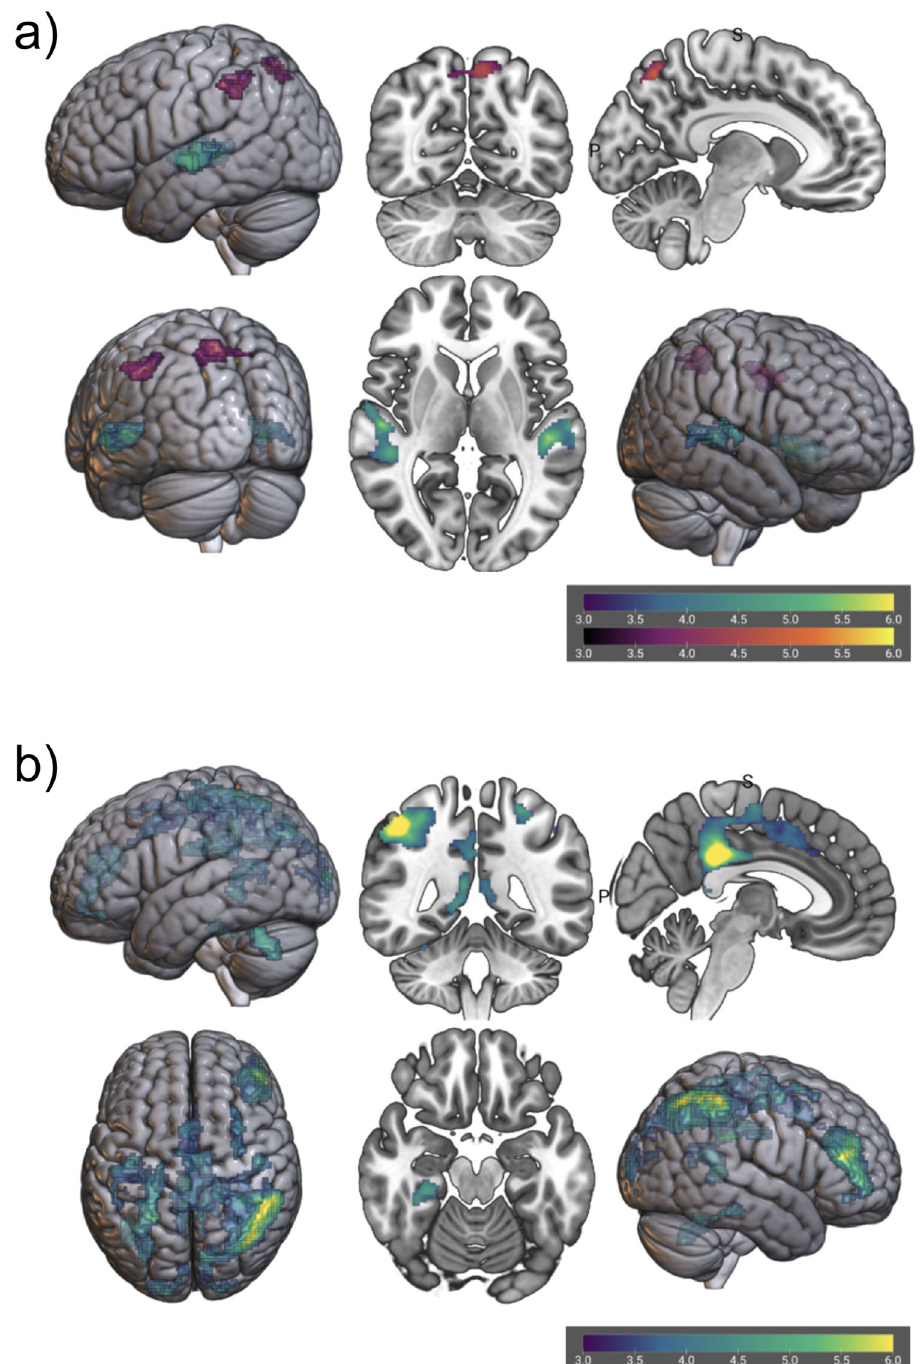
Fig. 2 Whole-brain analysis results for literariness and emotional intensity ( N = 52). a Brain correlates of appraised literariness during narrative engagement signi fi cant at permutation-based combined cluster-voxel-extent threshold (positive correlates in purple and negative correlates in cyan). The general linear model parametrically modelled semantic events for literariness. All within-cluster voxels are family-wise error corrected at p < 0.05. b Brain correlates of appraised emotional intensity during narrative engagement signi fi cant at permutation-based combined cluster-voxel-extent threshold (only negative correlates survived thresholding, in cyan). The general linear model parametrically modelled semantic events for emotional intensity. All within- cluster voxels are family-wise error corrected at p <